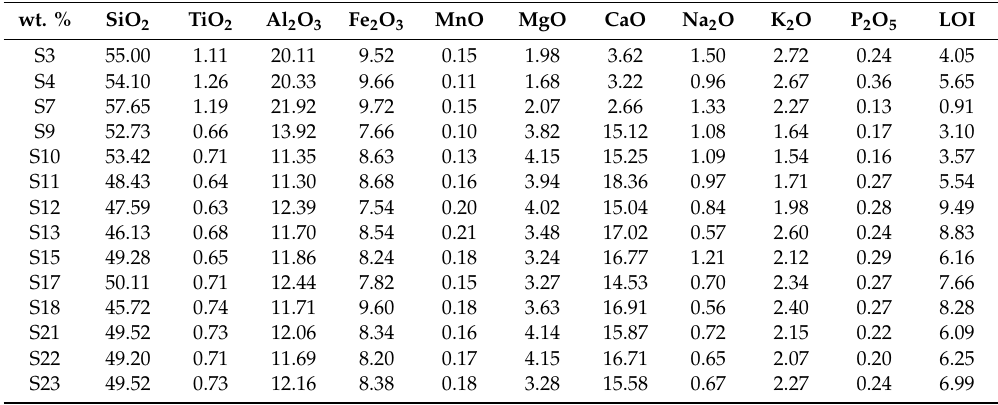
Table 5. Chemical composition of major elements of the architectural earthenwares by XRF analysis, expressed in wt. %. LOI: loss on ignition at 950 ◦